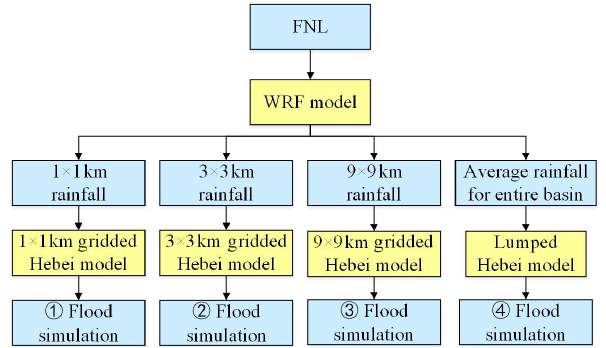
Figure 10. The coupled atmospheric–hydrologic system.